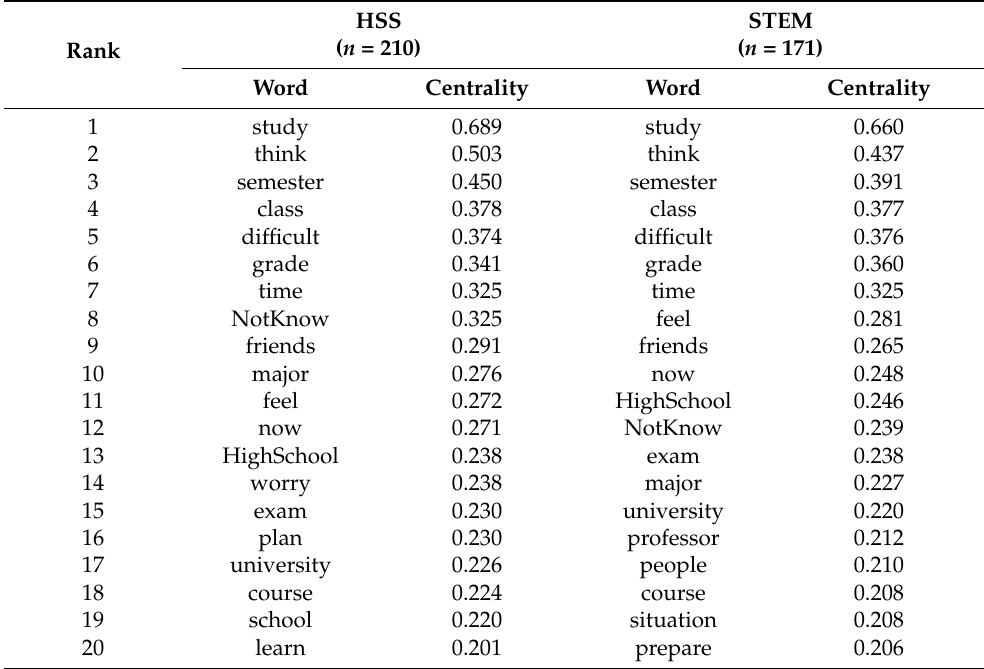
Table 3. Centrality of the top-ranked words for HSS and STEM tracks.